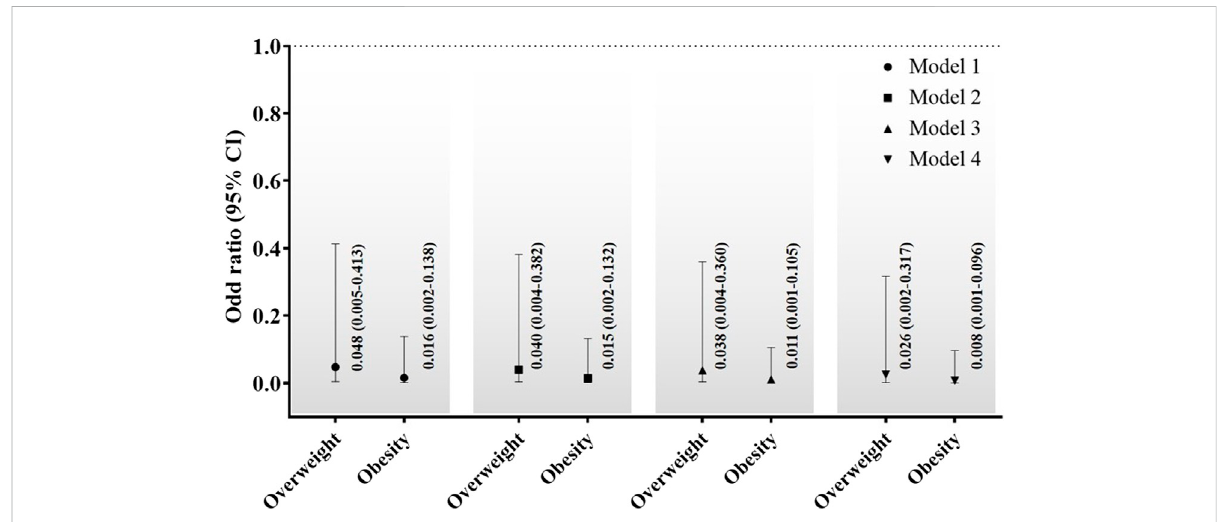
FIGURE 3 Comparisons of the odds ratios for overweight and obesity of sarcopenia group. CI; con fi dence interval. Model 1, no adjustments; Model 2, adjustedforage,gripstrength,FTSS,TUG,gaitspeed,moderate-to-vigorousphysicalactivity,andsedentarytime;Model3:adjustedforage,TG,TC, LDL-C, HDL-C, testosterone, and creatinine; and Model 4: adjusted for potential confounders including variables in Model 2 and Model